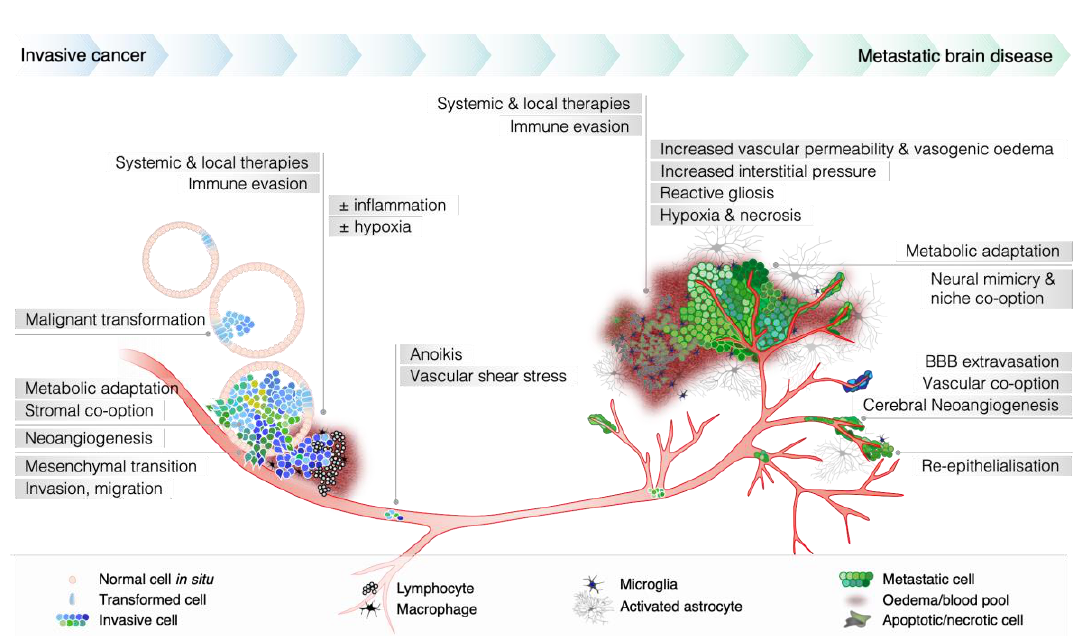
Figure 1. Schematic illustrating pathophysiological aspects of metastasis to the brain. Brain metastasis is an inefficient process marked by high rates of cellular attrition, and impacted by a myriad of selection pressures that drive clonal evolution. This includes requirements intrinsic to the metastatic cascade (capabilities for “metastatic fitness” are indicated in horizontal tracks) as well as extrinsic factors that drive the selection of particular tumor cell clones able to successfully establish brain metastases (vertical tracks; e.g., chemotherapy, radiotherapy or surgery) (adapted from [46] ).